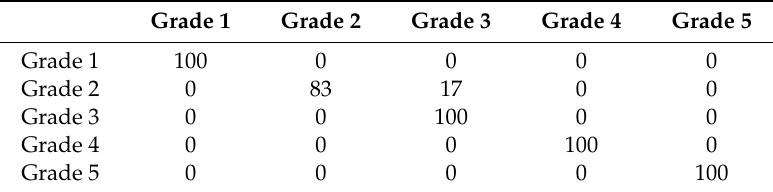
Table 15. System performance for intensity